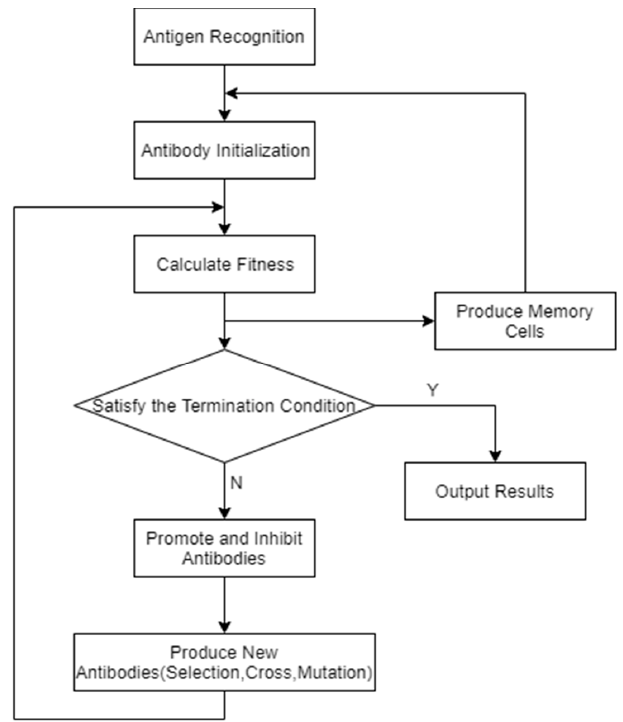
Figure 1. An illustration of the immune algorithm.